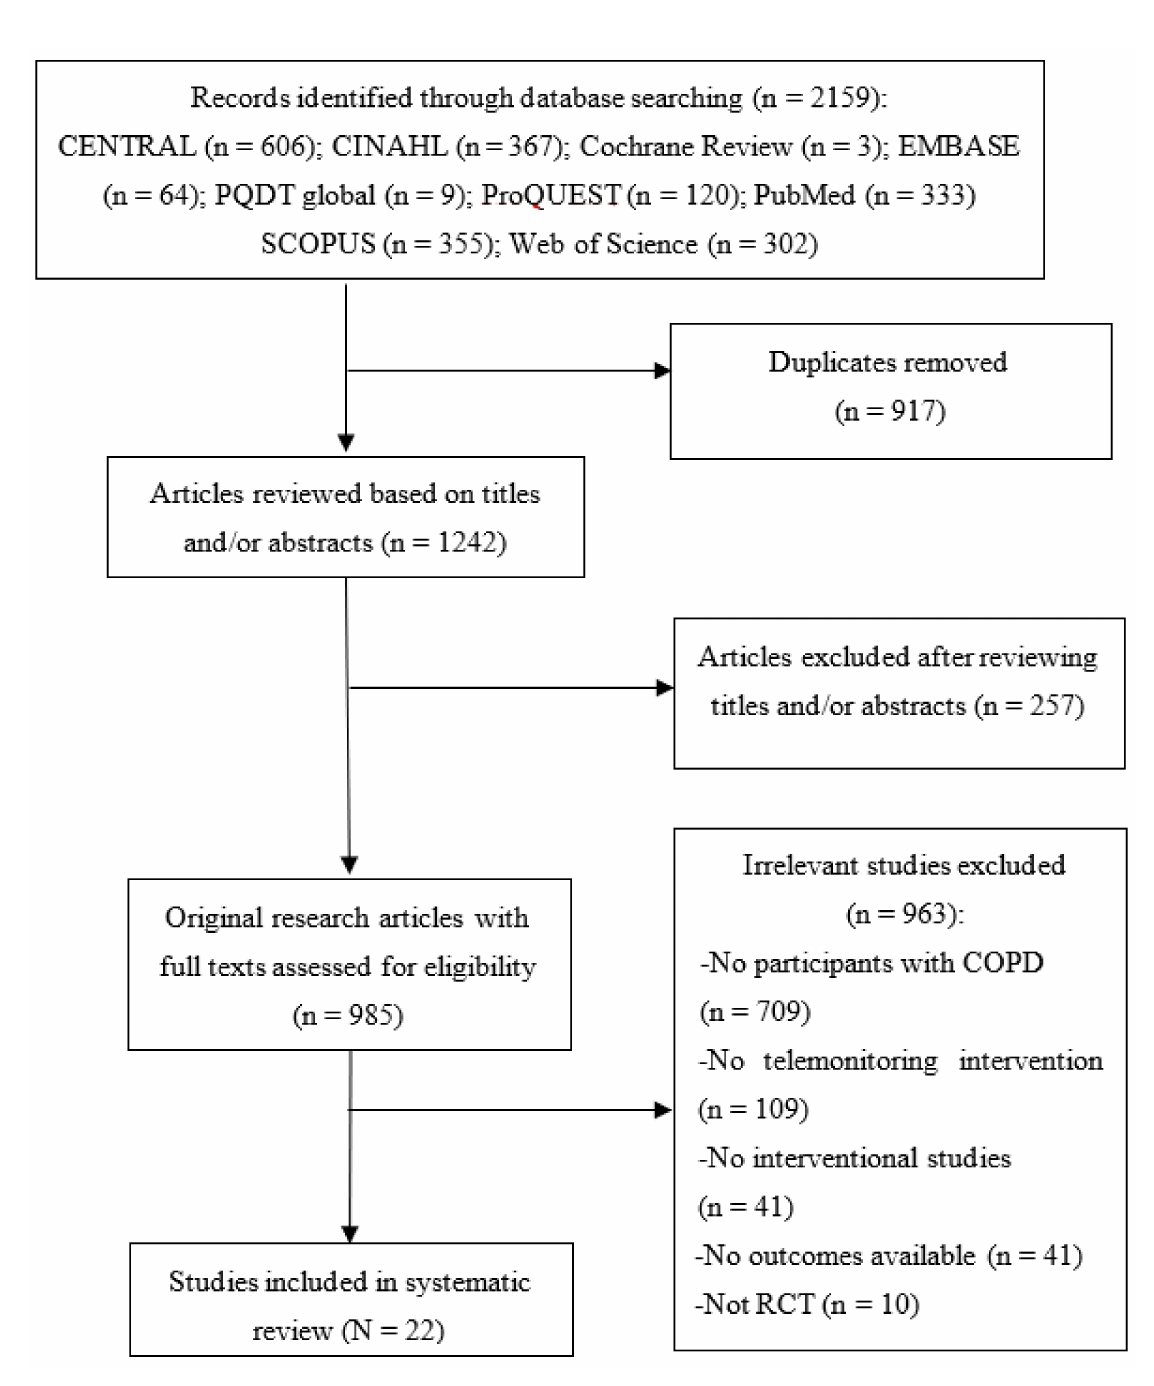
Figure 1. PRISMA flow chart of study